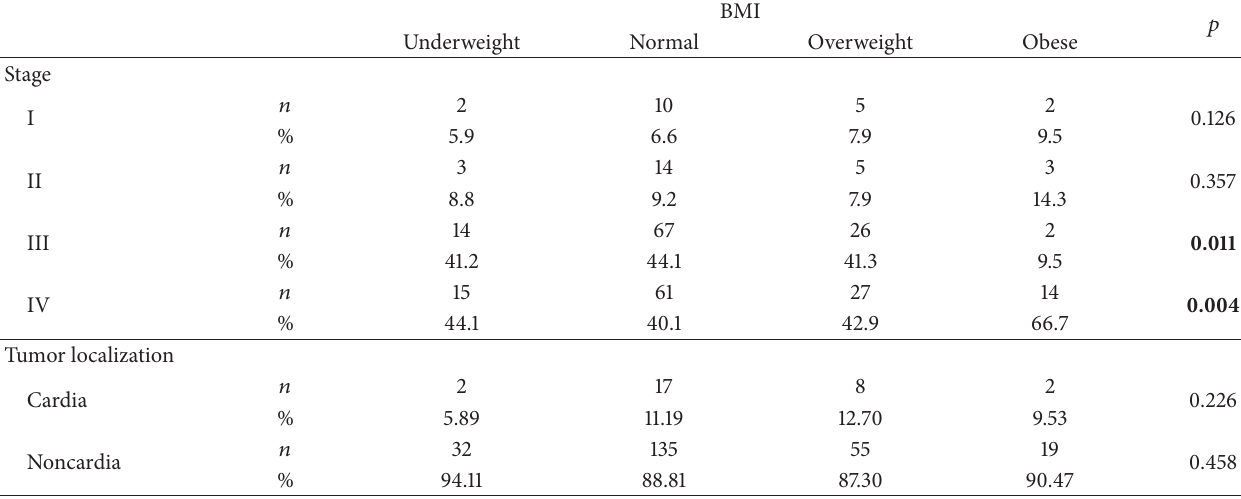
Table 3: Comparison between type of gastric surgery and body mass index in gastric cancer patients.